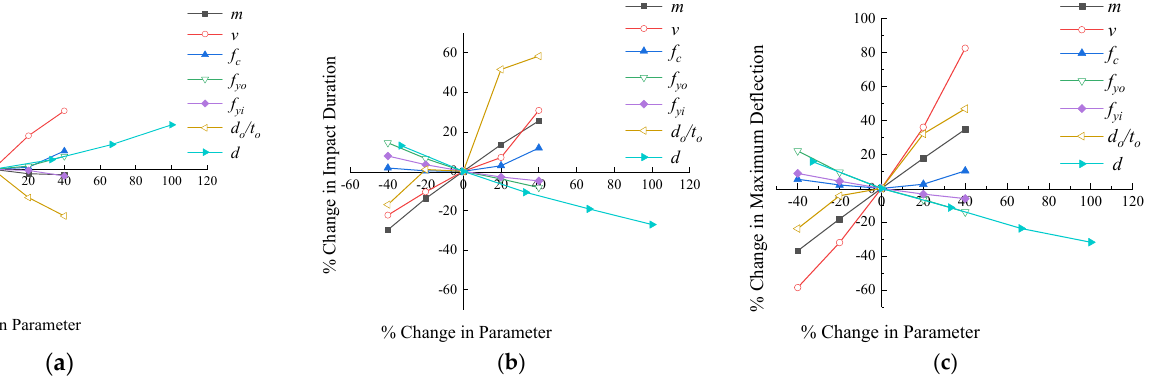
Figure 14. Sensitivity of R-ST corresponding changes to change in structure-related variables. ( a ) Peak impact force; ( b ) Impact duration; ( c ) Maximum deflection.